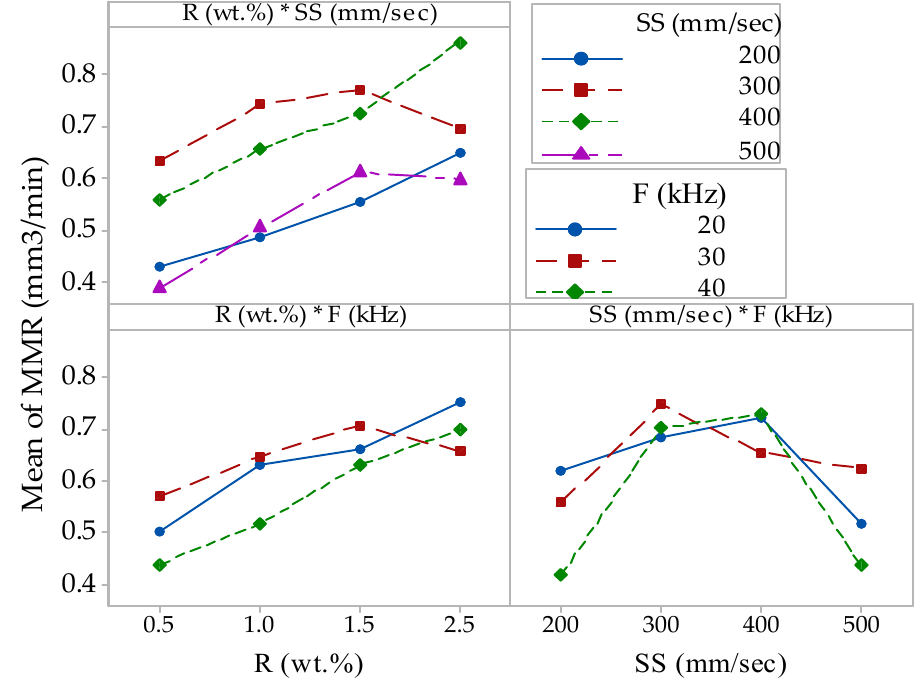
Figure 9. Main effect interaction plot for Figure 9. Main e ff ect interaction plot for MRR.